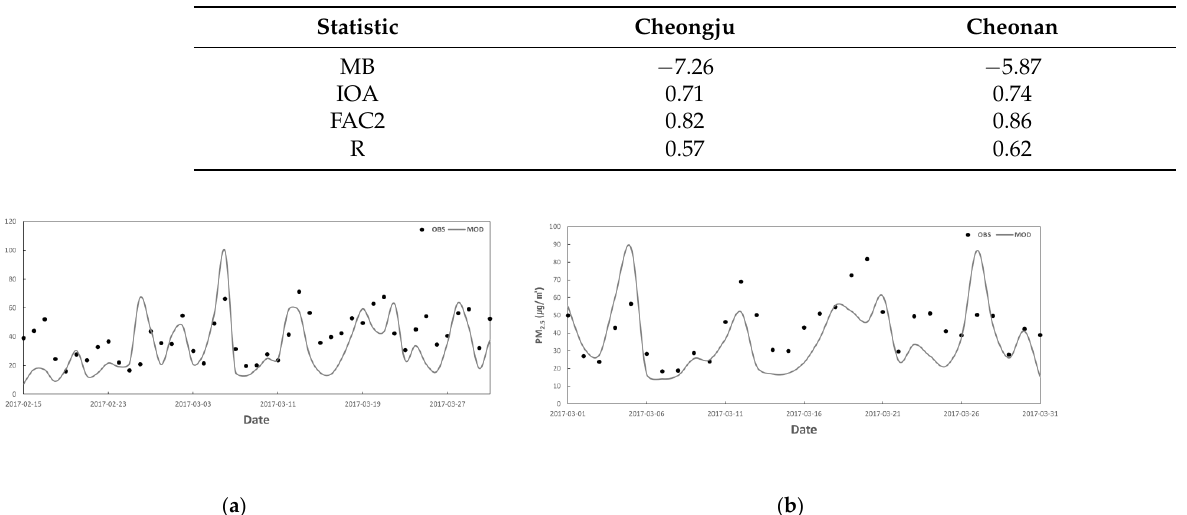
Figure 7. Observed and simulated PM 2.5 concentration in March 2017 at ( a ) Cheongju station in Chungbuk province and ( b ) Cheonan station in Chungnam province. Table 7. Statistical parameters for simulated PM 2.5 concentrations.